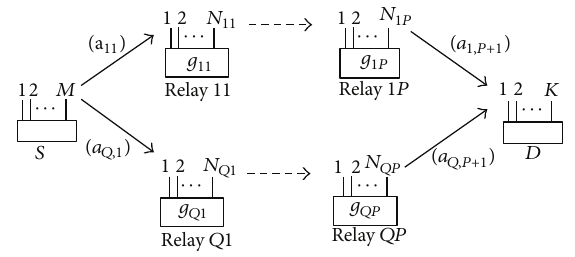
Figure 1: Multihop AF relay